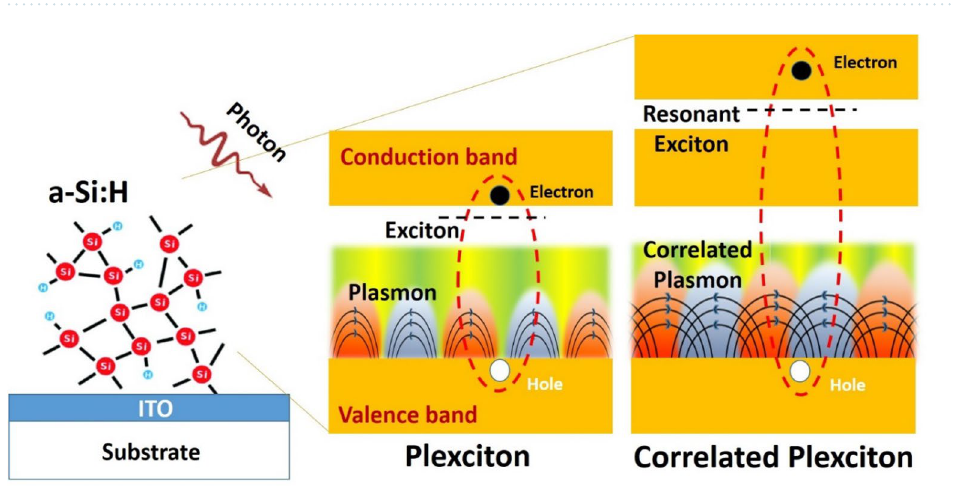
Figure 2. ( a–d ) Real part <ε 1 > of the dielectric function, ( e–h ) reflectivity, and ( i–l ) loss function (E 0 : conventional plasmon, E